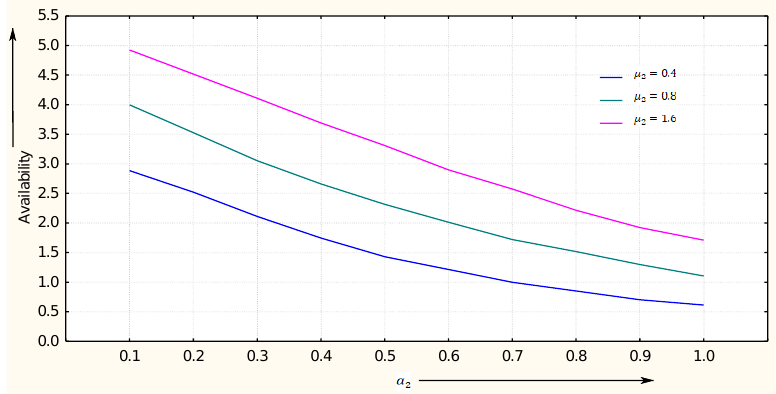
Figure 9. Behaviour of availability w.r.t 𝛼